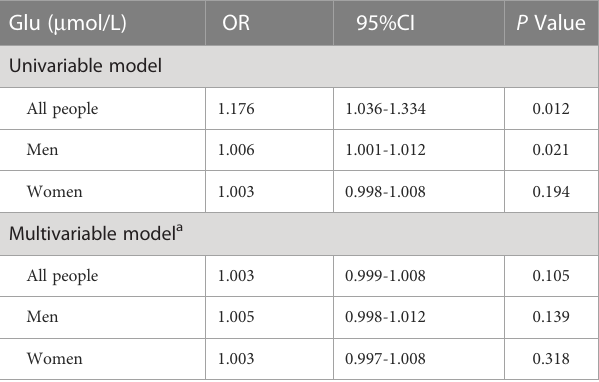
TABLE 2 Relationship between Glu and CVD in patients with type 2